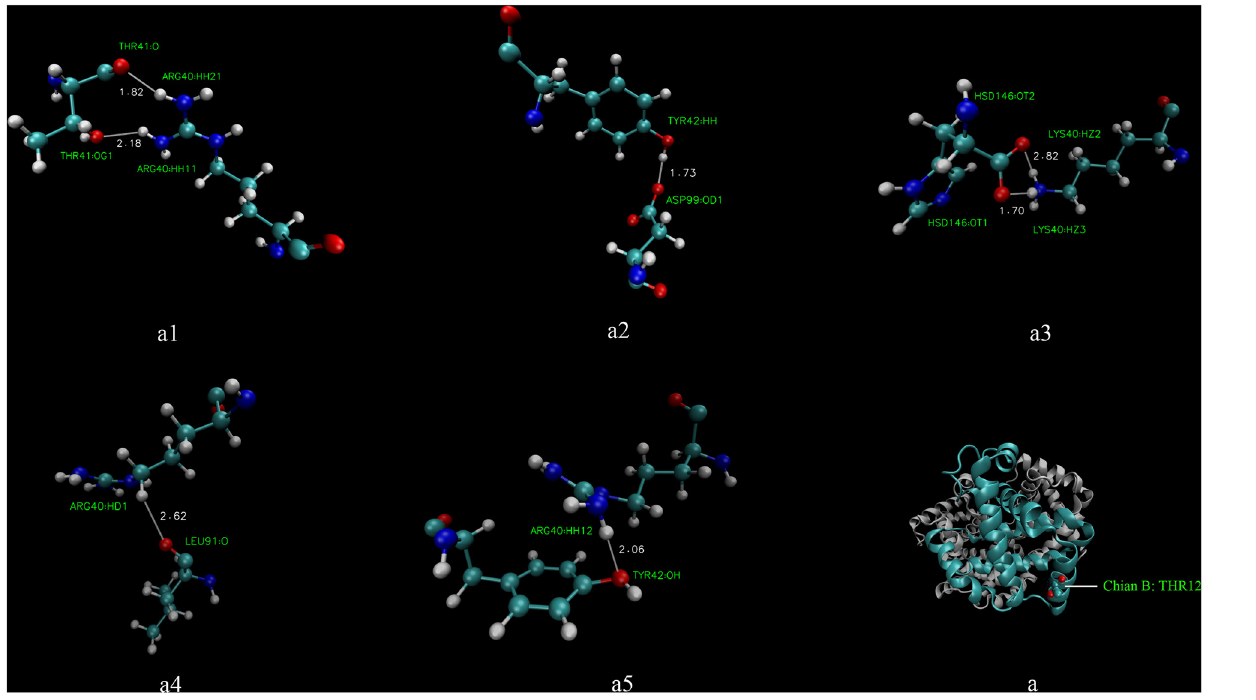
Fig 5. The loss of 7 hydrogen bonds at α 2 β 1 interface in hwHb1. (a1 – a5) Hydrogen bonds at α 2 β 1 interface present in hsHb1 and lost in hwHb1, (a) Three-dimensional structure of hsHb1 with β 12Met.